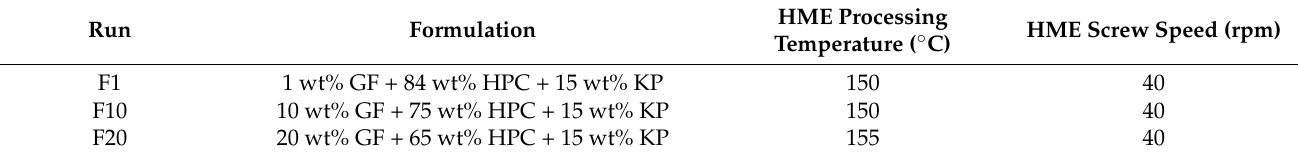
Table 1. Compositions of the filament